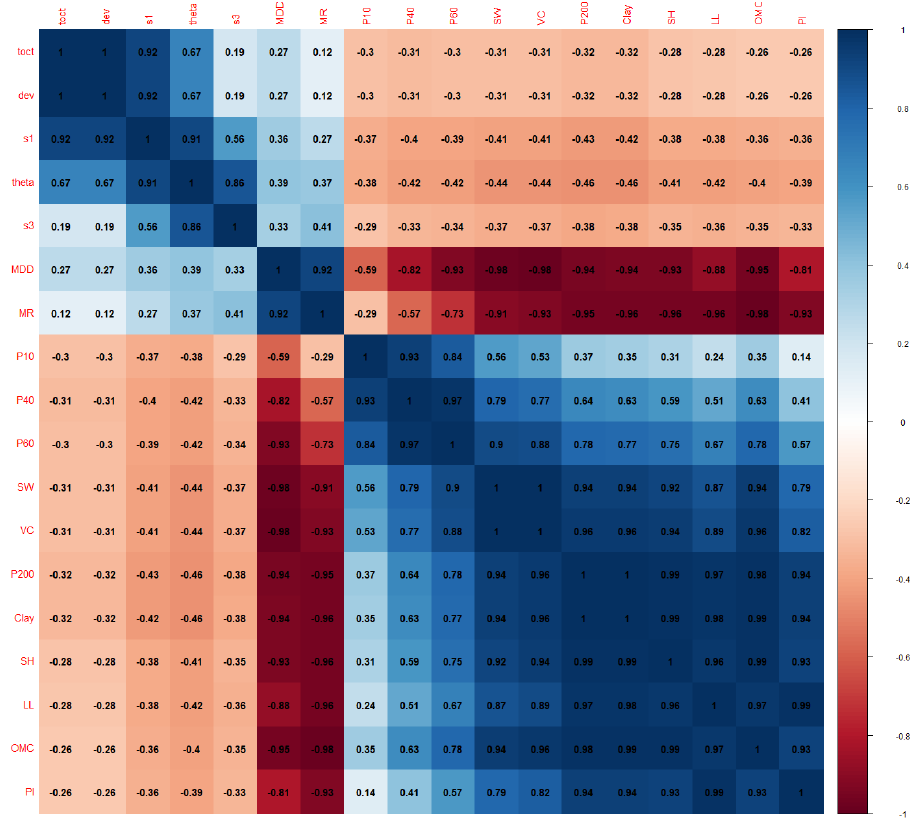
6 of 15 Table 2. Summary of variables. Variable